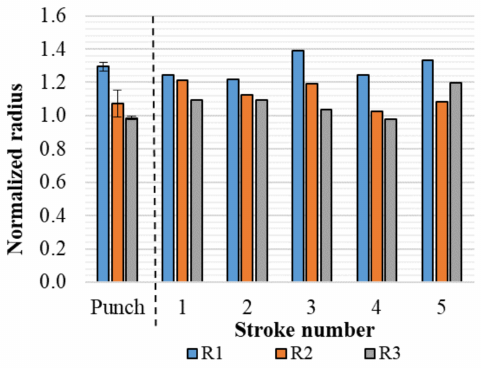
Figure 9. Measured radius of workpiece as function of no. strokes and of punches normalized with respect to nominal dimensions.